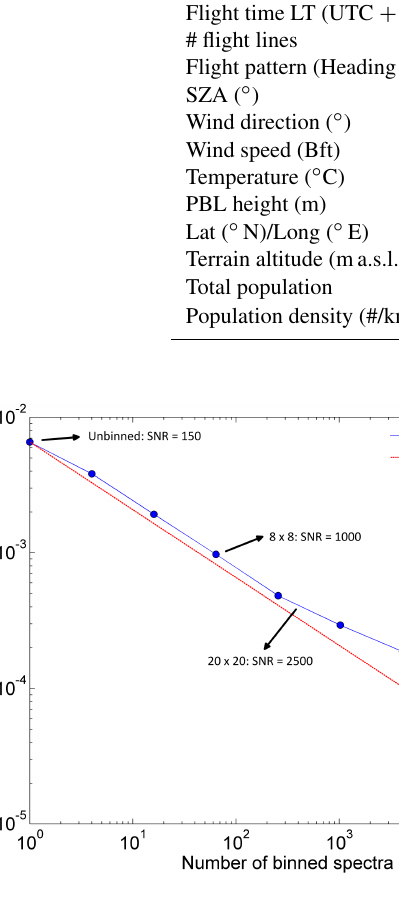
Figure 3. Allan plot illustrating the impact of spatial binning of the raw spectra on the rms of the noise, plotted on a double logarithmic